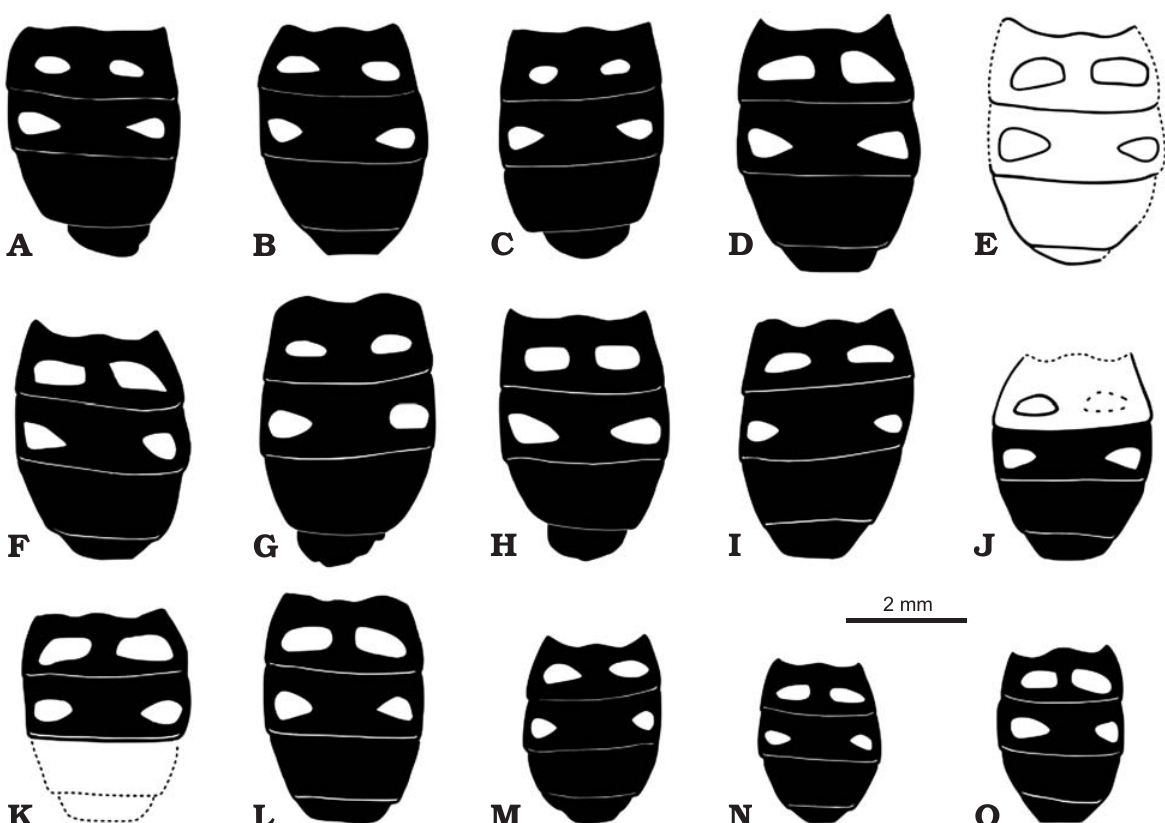
Fig. 7. Pipizine hoverfly Oligopipiza quadriguttata Nidergras, Hadrava, and Nel gen. et sp. nov., Rupélian, Céreste, France. Reconstructions of abdomens of all type specimens. A . RNGL-S1 (holotype, male). B . RNGL-S2 (female). C . RNGL-S3 (male). D . RNGL-S4 (female). E . RNGL-S5 (female). F . RNGL-S6 (female). G . RNGL-S7 (male). H . RNGL- RNGL-S8 (male). I . RNGL-S9 (female). J . RNGL-S10 (female). K . RNGL-S11 (female). L .